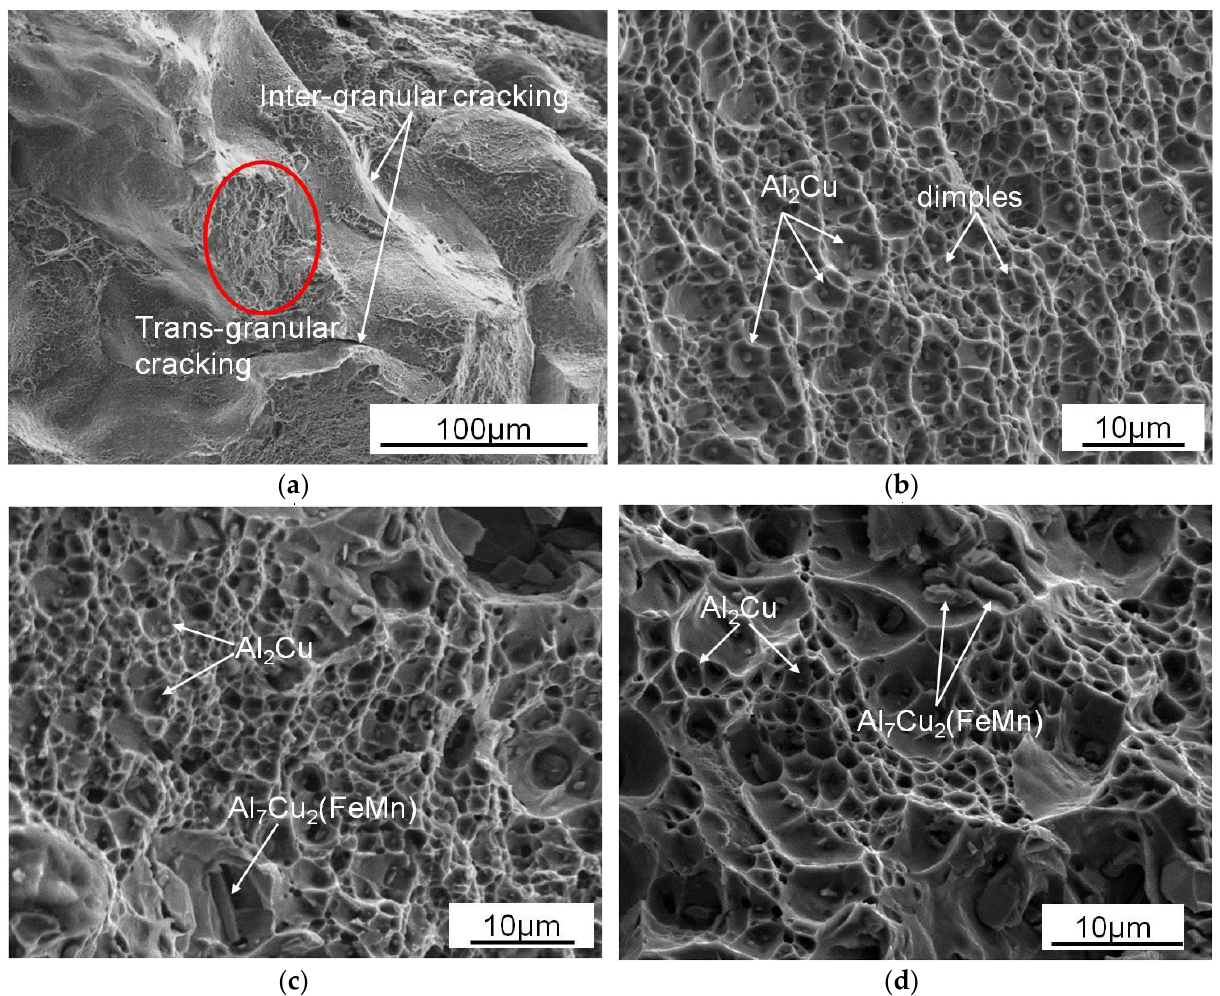
Figure 6. Scanning electron microscopy (SEM) images of aged alloys with Fe contents: ( a ) 0.10 wt.% and ( b ) 0.20 wt.%.